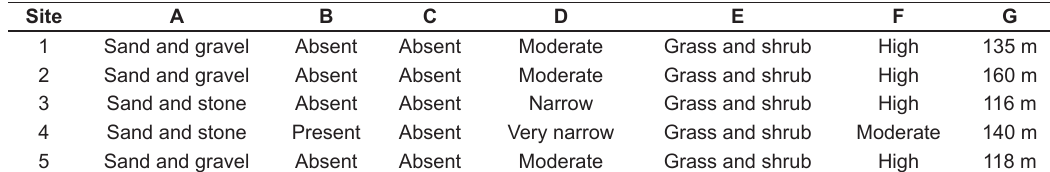
Figure 1. Location of the collection points of fish on the Umari reservoir, the hydrographic basin of the Apodi-Mossoró river, Rio Grande do Norte, Brazil. Table 1. General characteristics of collection points in the Umari reservoir, Rio Grande do Norte,